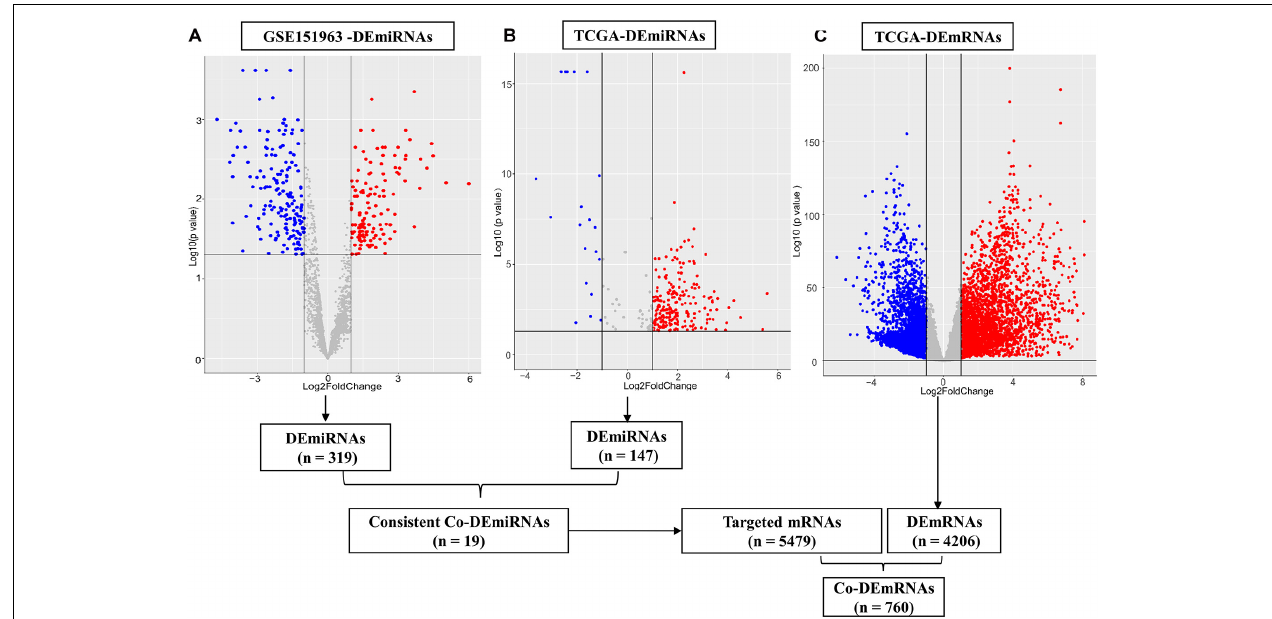
FIGURE 2 | Differential expression of miRNAs and mRNAs. (A) Differential expression (DE) miRNAs in patient cohort (GSE151963), (B) DEmiRNAs in TCGA and (C) DEmRNAs in the TCGA dataset. The red plots show the upregulated expression of miRNA or mRNA; the blue plots show the downregulated expression of miRNA or mRNA; the gray plots show the normal expression of miRNA or mRNA. DE, differential expression; Co-DE, common differentially expressed; miRNA, microRNA; mRNA, messenger RNA.